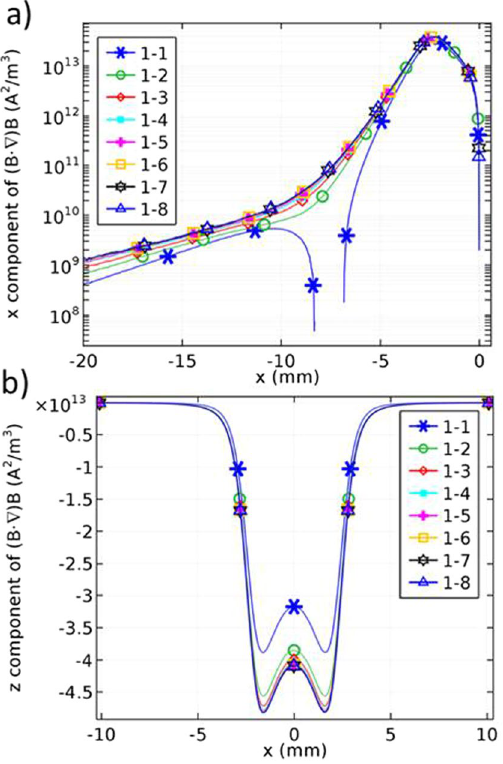
Figure 7. ( a ) x component and ( b ) z component of ( B · ∇ ) B for a = 1 and b = 1 to 8 at z = − 1 mm along the microchannel.